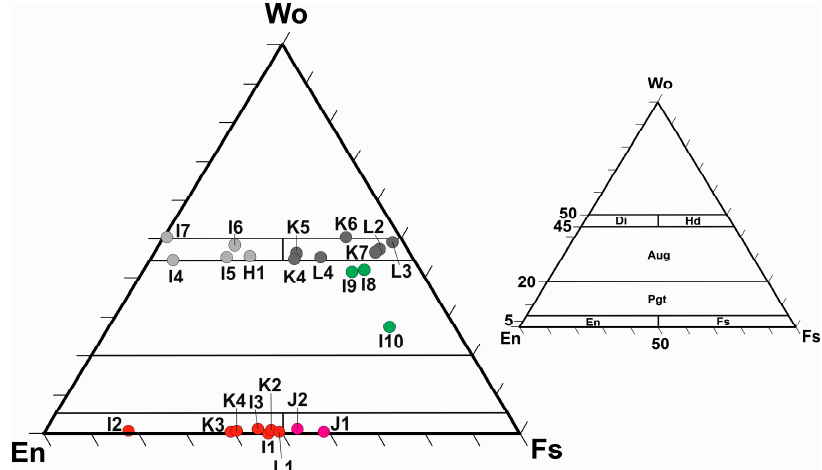
Figure 15. Classification diagram for identified pyroxenes in samples collected from the Northern Portuguese continental shelf by combining the classification diagrams of clinopyroxenes and orthopyroxenes proposed by [48]. The classification shows the presence of diopside (Di), hedenbergite (Hd), augite (Aug), enstatite (En), and ferrosilite (Fs). Pigeonite (Pgt) was not found. The capital letters next to each dot indicates the location of the sample on the map of the Figure 10. Each number next to each capital letter is the reference of the analyzed mineral grain.